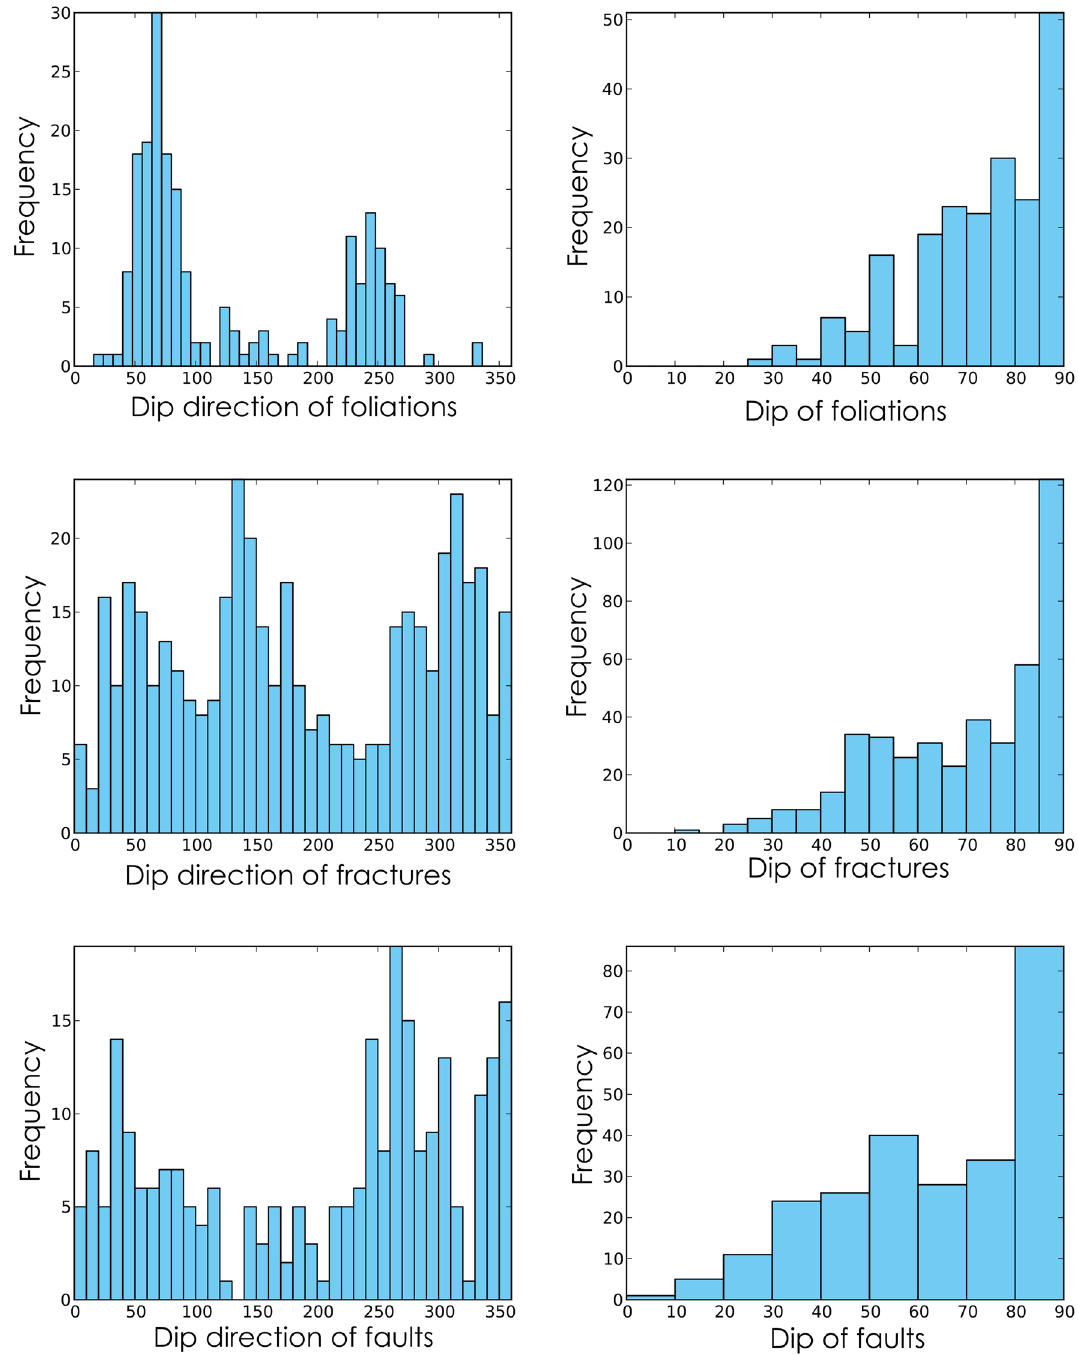
Figure 5. ( a , b ) Histograms plotted for dip direction and the dip amount of foliations, ( c , d ) Histograms plotted for dip direction and dip of fractures, ( e , f ) Histograms plotted for dip direction and dip of ern parts of the ADMB. The ADMB consists of predominantly low-grade metamorphic rocks except for a few patches of granulites such as Ambaji granulite (study area), Sandmata granulite, and Pilwa-Chinwali granulites 37 . The Ambaji granulite has multiply deformed at different stages and subsequently uplifted through the exhu- mation process from the lower-middle earth crust 37,38 . The granulite has intruded by three distinct granites namely G1 (gneissic structure), G2 (coarse-grained) which is found to be predominant in the study area, and G3 (fine to medium-grained occurs as a vein). In contrast to these granitic rocks, the other medium and high- grade rocks in the Ambaji basin are comprised of quartzite, mafic- and calcareous-granulite. The ages of three different granites G1, G2, and G3 are 860 Ma, 840 Ma, and 759 Ma respectively 37 . The rocks in this region are highly fractured and both large-scale brittle- and ductile shear zones have been developed due to multiple defor- mation events. Further, the area is bounded by two major faults i.e., the Surpagla-Kengora fault in the east and